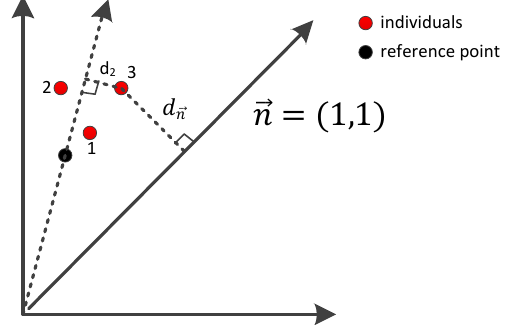
Figure 4. Illustration of the extension distance when m =